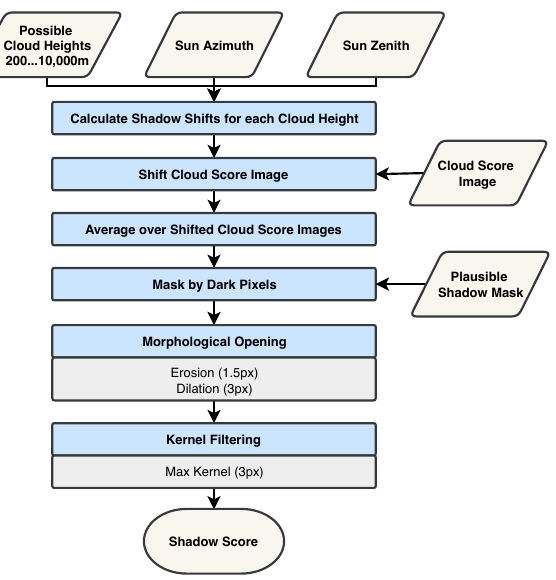
Figure 4. Flowchart of the Shadow Score module, which produces a scalar cloud score characterizing the whole image regarding the amount of pixels affected by cloud